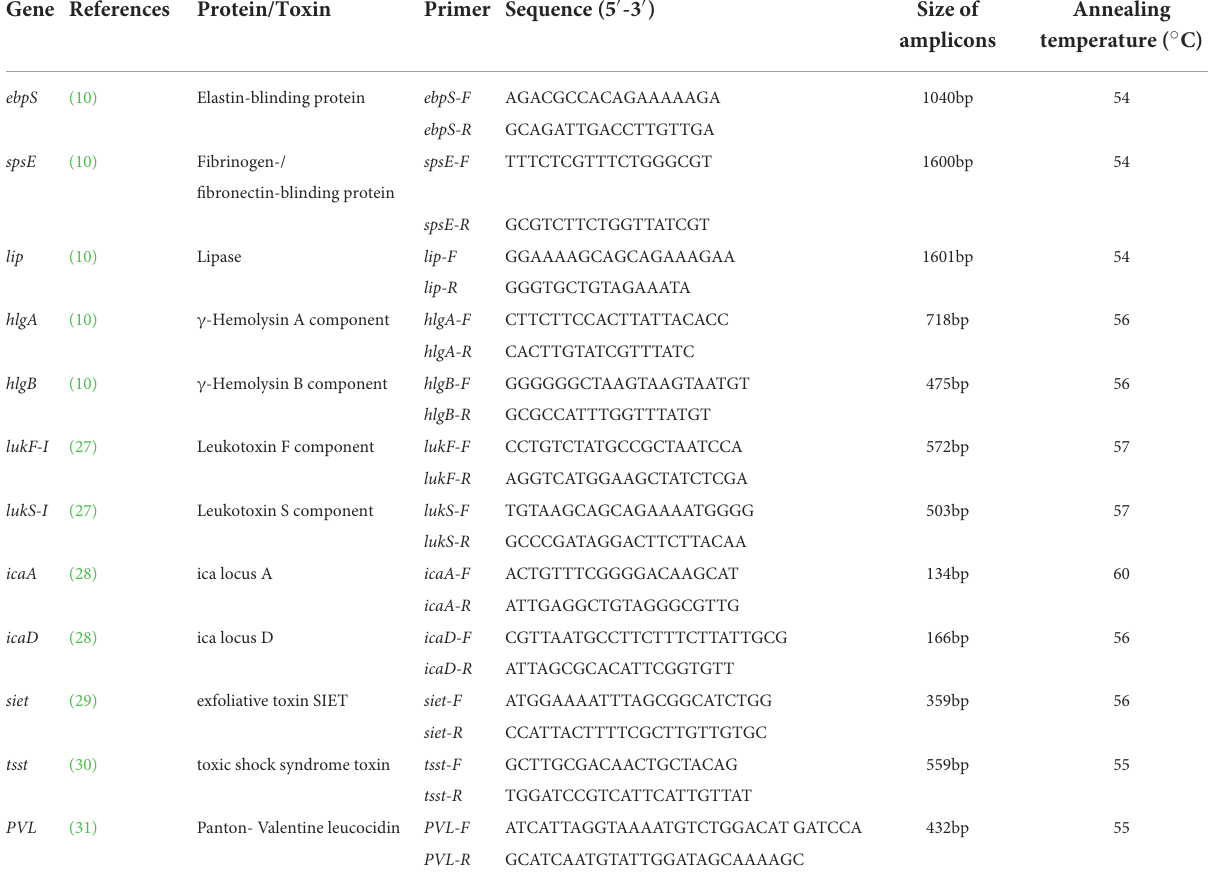
TABLE 1 Primers, amplicon size, sequence, and annealing